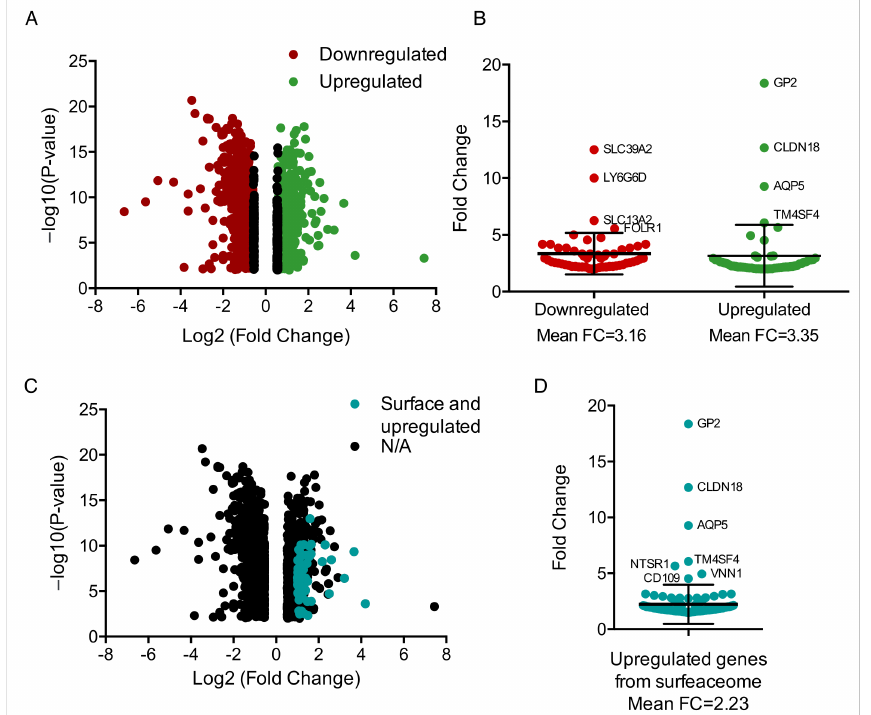
Figure 1. Mapping transcriptomic differences in CRC tumors based on BRAF mutated status. ( A ). Volcano plot showing statistically significant deregulated genes between BRAF wt and mu- tant CRC samples, highlighted in color those deregulated genes with an expression decrease (red) or increase (green) equal or higher than 2 folds. ( B ). Dot plot representing the fold change of upregulated and downregulated genes selected in A where error bars are the mean with the standard deviation (SD). ( C ). Same volcano plot as in A, with upregulated and surfaceoma expressed genes in turquoise. ( D ). Dot plot of genes selected in C with error bars representing mean FC and